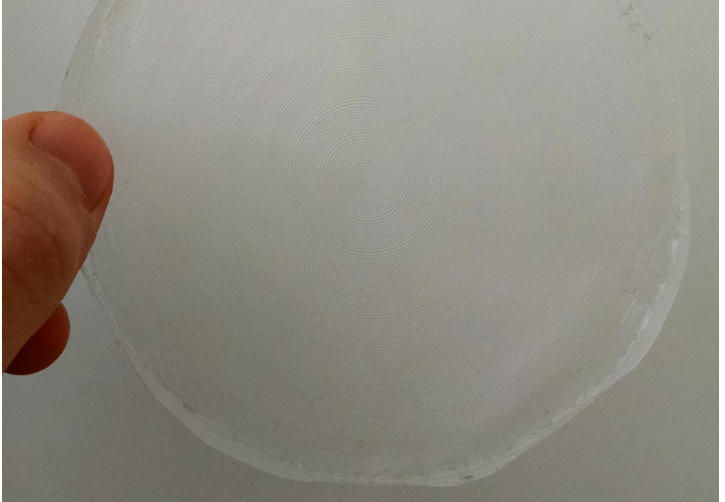
Figure 5. Thin transparent film of functionalized PE_HEMA obtained via solution casting.